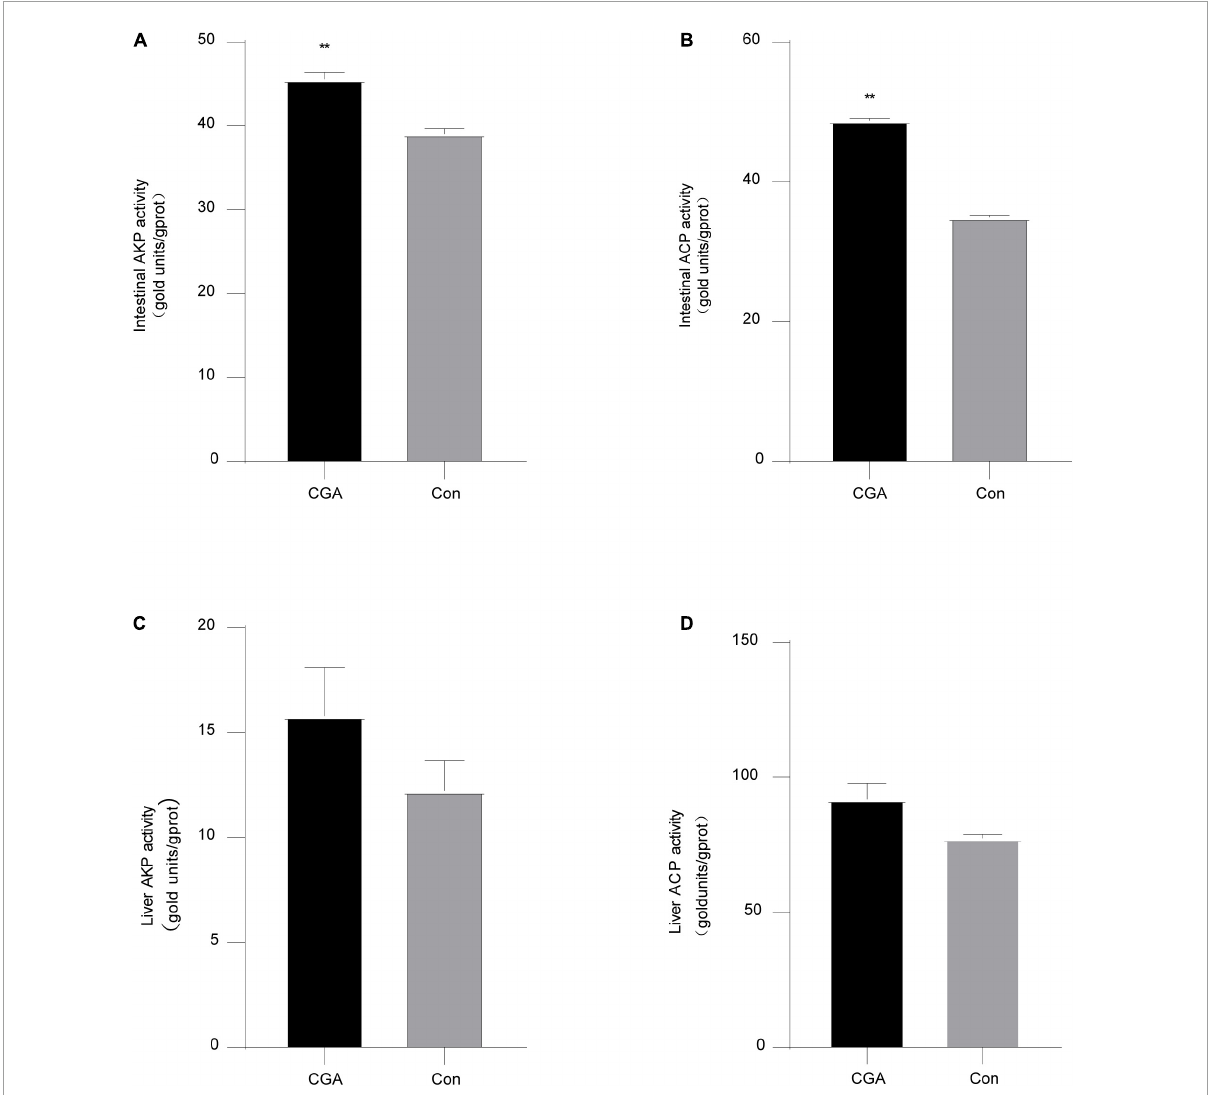
FIGURE3 Intestinal and liver non-specific immune enzyme activities. (A) Alkaline phosphatase (AKP) activity in intestinal tissue. (B) Acid phosphatase (ACP) activity in intestinal tissue. (C) AKP activity in liver tissue. (D) ACP activity in liver tissue. **Indicates a significant difference compared with the control group ( P < 0.01). Acid phosphatase (ACP), alkaline phosphatase (AKP). The acronym for the chlorogenic acid (CGA)-added group is CGA and the acronym for the control group is